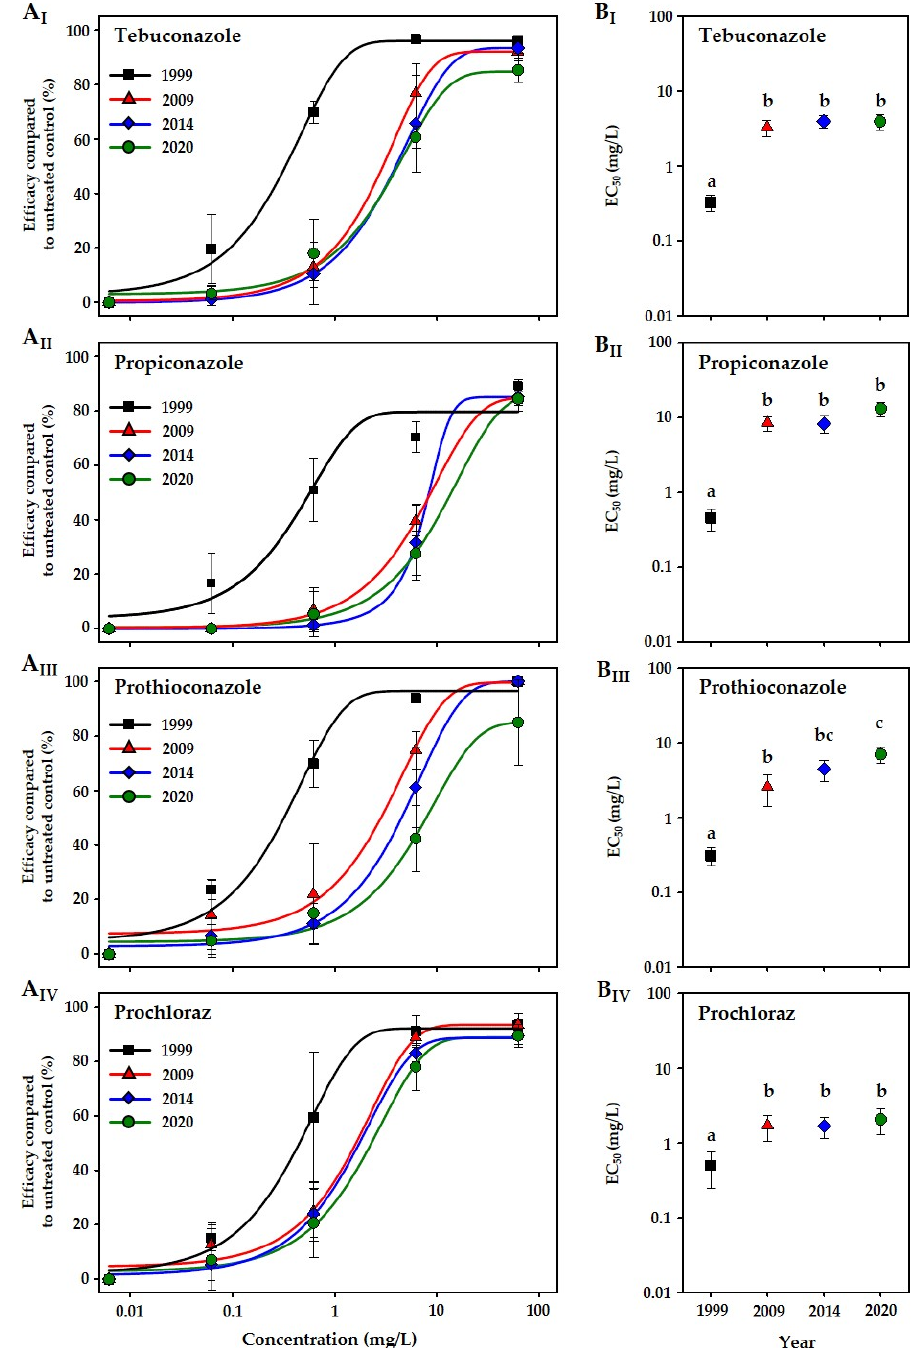
Figure 2. Changes in fungicide sensitivity of Zymoseptoria tritici field populations isolated in Northern Germany from two locations between 1999 and 2020 (isolation years 1999, 2009, 2014, 2020) to the demethylation inhibitors (DMIs) tebuconazole ( A I , B I ), propiconazole ( A II , B II ), prothioconazole (triazoles) ( A III , B III ) and prochloraz (imidazole) ( A IV , B IV ) using microtiter assays. ( A I – A IV ) Relationship between fungicide concentration and fungicide efficacy. Efficacy data (mean ± SD) of the several fungicide concentrations are expressed as a percentage reduction of fungal growth compared to the untreated control. Means ( ± SD) were calculated for each year of Z. tritici isolation and each concentration including both locations and three replications per location. ( B I –B IV ) Comparison of EC 50 values (mg/L). EC 50 values (mean ± SD) were determined as the fungicide concentration reducing fungal growth by 50%. Means ( ± SD) were calculated from EC 50 values of both locations and three replications per location. Different letters describe significant differences in EC 50 values between years. Statistical significance was evaluated at p ≤